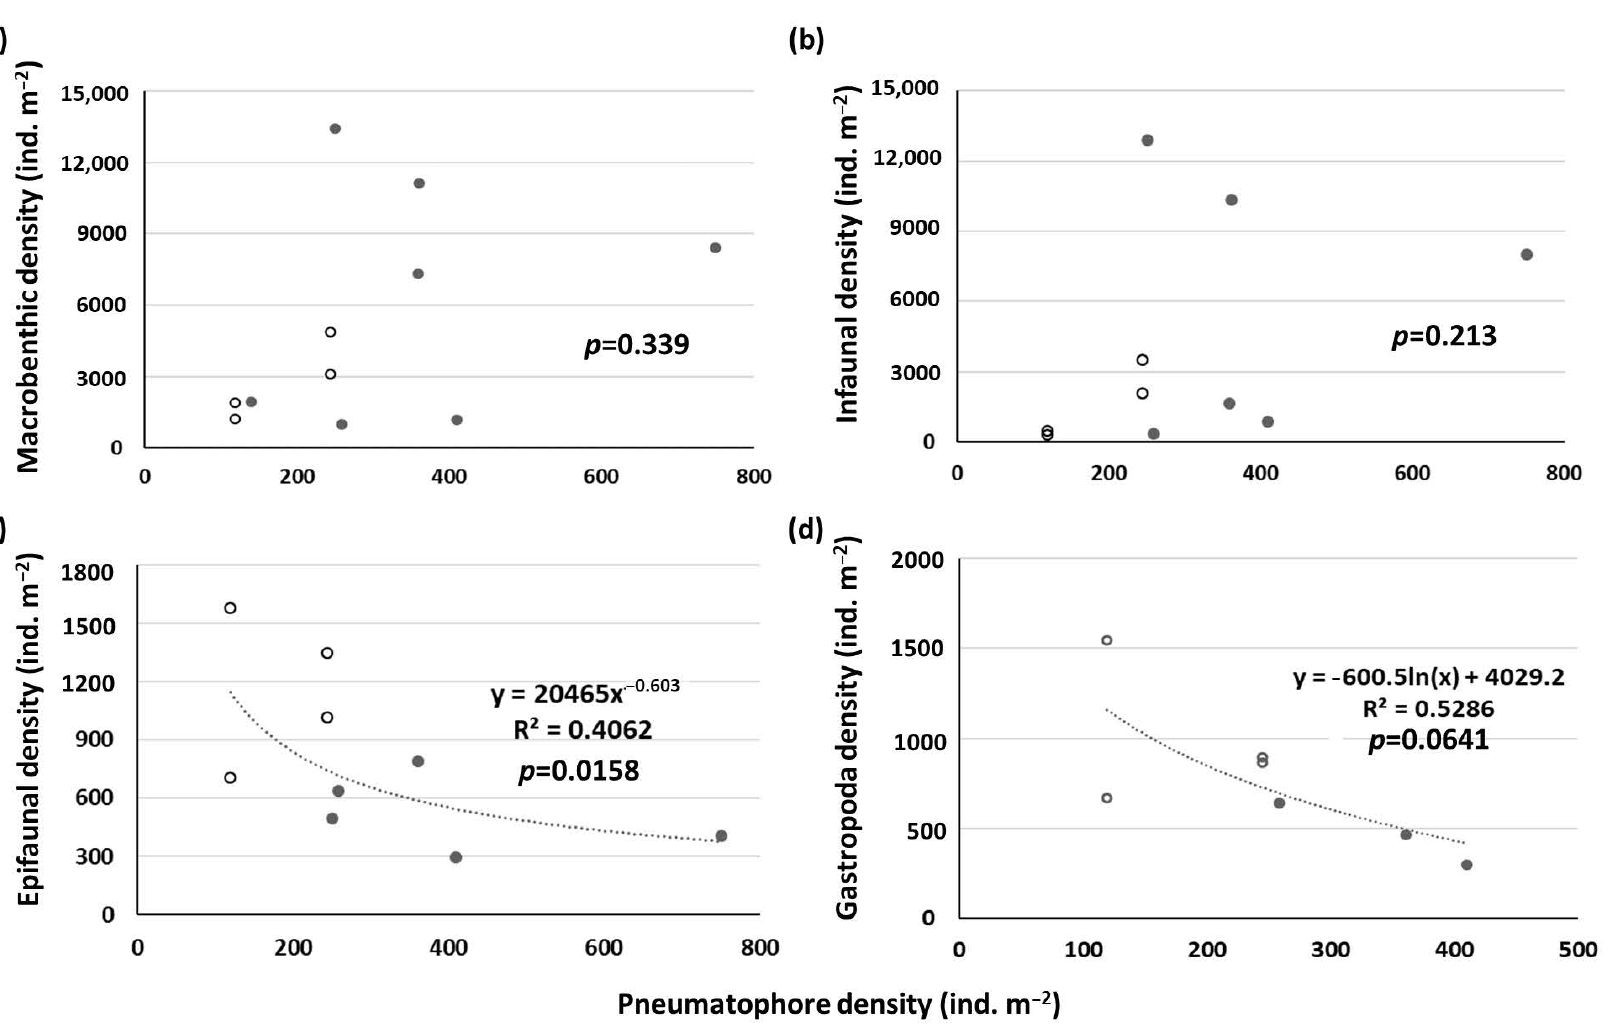
Figure 8. Relationships between the densities of ( a ) macrobenthos, ( b ) infauna, ( c ) epifauna, and ( d ) gastropods and Avicennia marina pneumatophore density. White dots: this study; black dots: prior